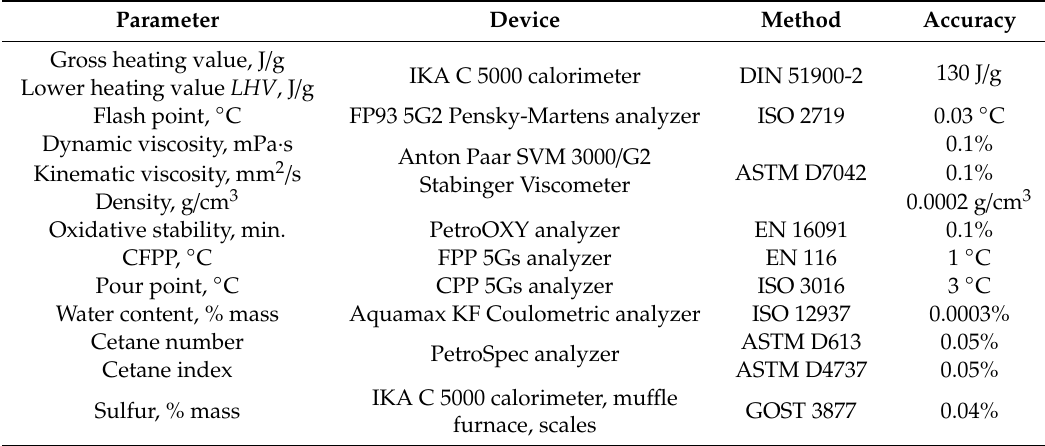
Table 2. The accuracy of fuel property measurement equipment.